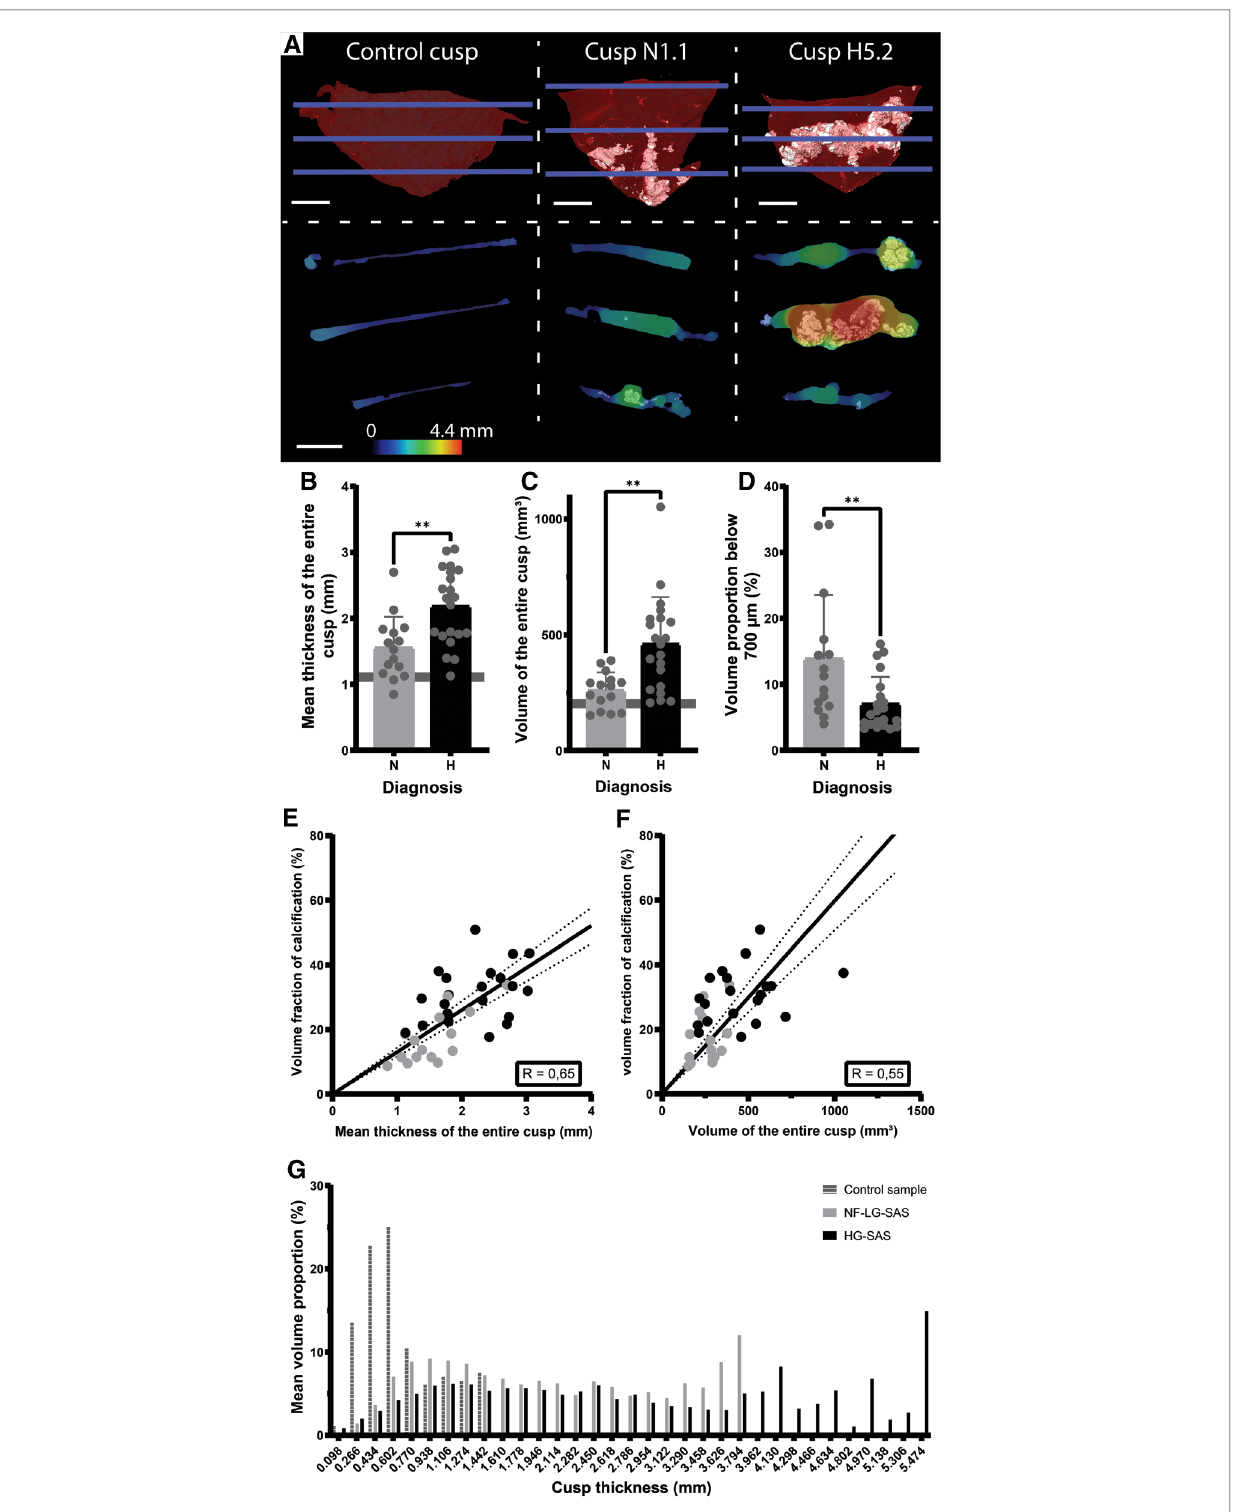
FIGURE 4 Quanti fi cation of the volume and thickness of the entire cusp. ( A ) 3D renderings (top) of the control cusp, sample N1.1 and H5.2 and ortho-slices (bottom) showing simultaneously the calci fi cations and the thickness values at three heights corresponding to the blue lines in the 3D renderings. For the 3D renderings, soft tissue is shown in red and calci fi cation in white. Scale bars=5 mm. Thickness is represented by the color scale bar. ( B – D ) Bar graphs comparing the mean thickness of the entire cusp ( B ), the volume of the entire cusp ( C ) and the volume proportion of the cusp with a thickness below 700 µm ( D ) for the NF-LG-SAS and HG-SAS groups. The horizontal line indicates the value for the control cusp, not shown on D for clarity (corresponding to 64.6%). ( E,F ) Correlations between the volume fraction of calci fi cation and the mean thickness of the entire cusp ( E ) and the volume of the entire cusp ( F ), respectively. Dotted lines indicate the 95% con fi dence bands. ( G ) Average histogram of the thickness distribution in terms of volume proportion for the control cusp, the NF-LG-SAS and HG-SAS cusps. N, NF-LG-SAS; H, HG-SAS, **: p